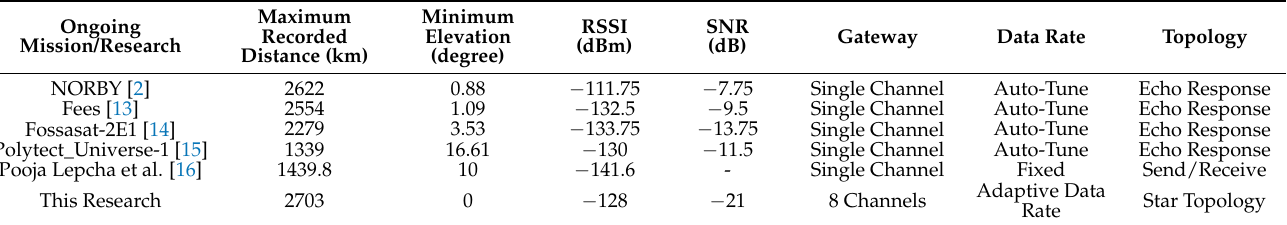
Table 1. Comparing this research with past research mentioning network topology and message response using LoRa.